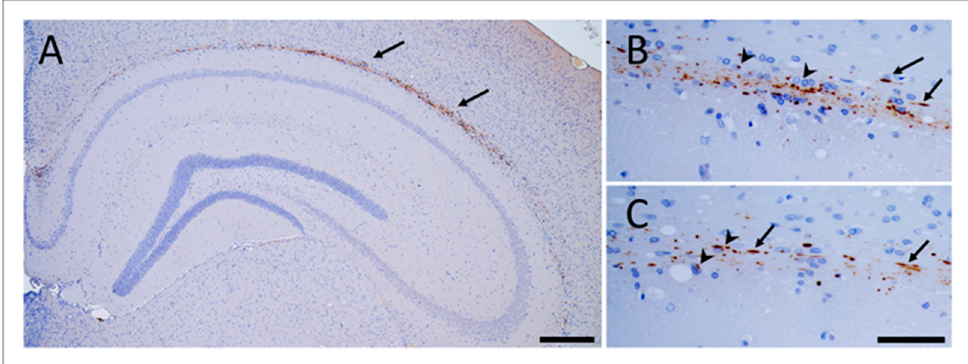
Figure 2. Tau pathology in bank voles inoculated with GSS-F198S. Hyperphosphorylated Tau aggregates in the brain of a BvM culled at 442 d.p.i., inoculated with GSS-F198S #3. Tau inclusions accumulated along the alveus (picture ( A ), scale bar 200 µm). In pictures ( B , C ), hyperphosphorylated Tau depositions are shown as neuropil threads (arrows) and coiled bodies (head arrows) (scale bar 50 µm). Immunostaining was performed with AT8 antibody.